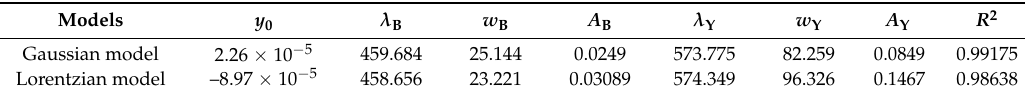
Table 1. Results of feature extraction and model selection.